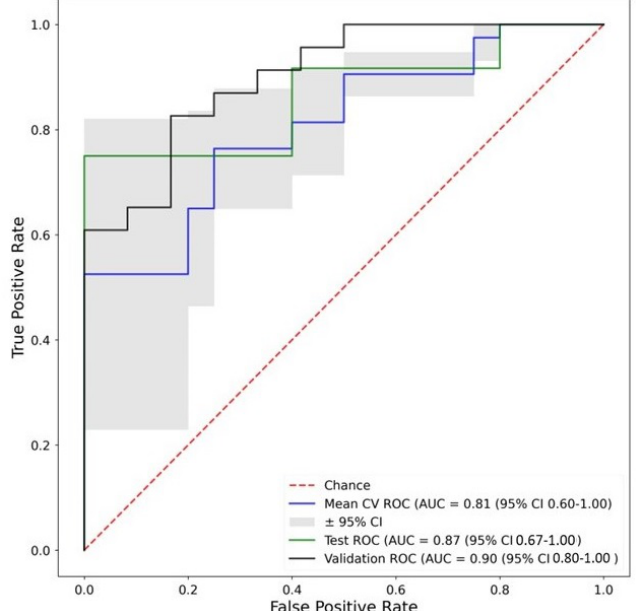
Figure 8. ROC curves of the best performing (by validation AUC) machine learning classifier trained on Fingerprint B—Neural Network. Corresponding Accuracies—Training: 0.78 , Test: 0.68, Validation: 0.81. Key : Mean CV ROC—Mean cross validation ROC from training dataset, Test ROC—ROC from test dataset, Validation ROC—ROC from validation dataset.